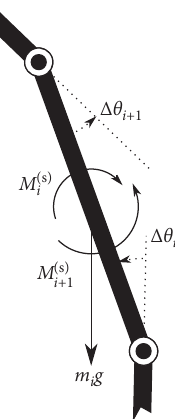
Figure 7: Forces applied on body ( i